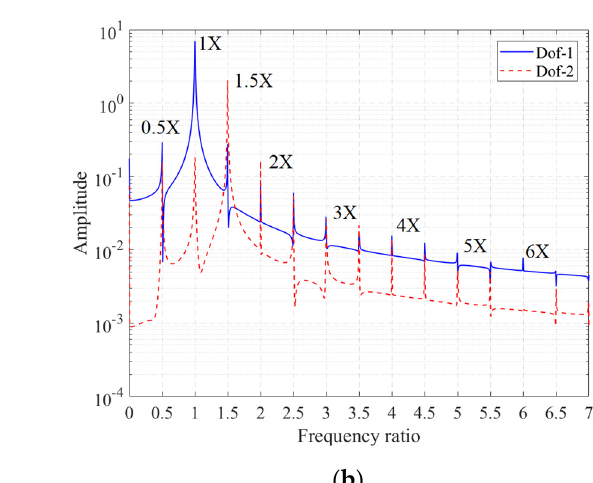
Figure 9. Time history and frequency spectra of the system with an excitation frequency of 0.97: ( a ) time history; ( b ) frequency spectrum.